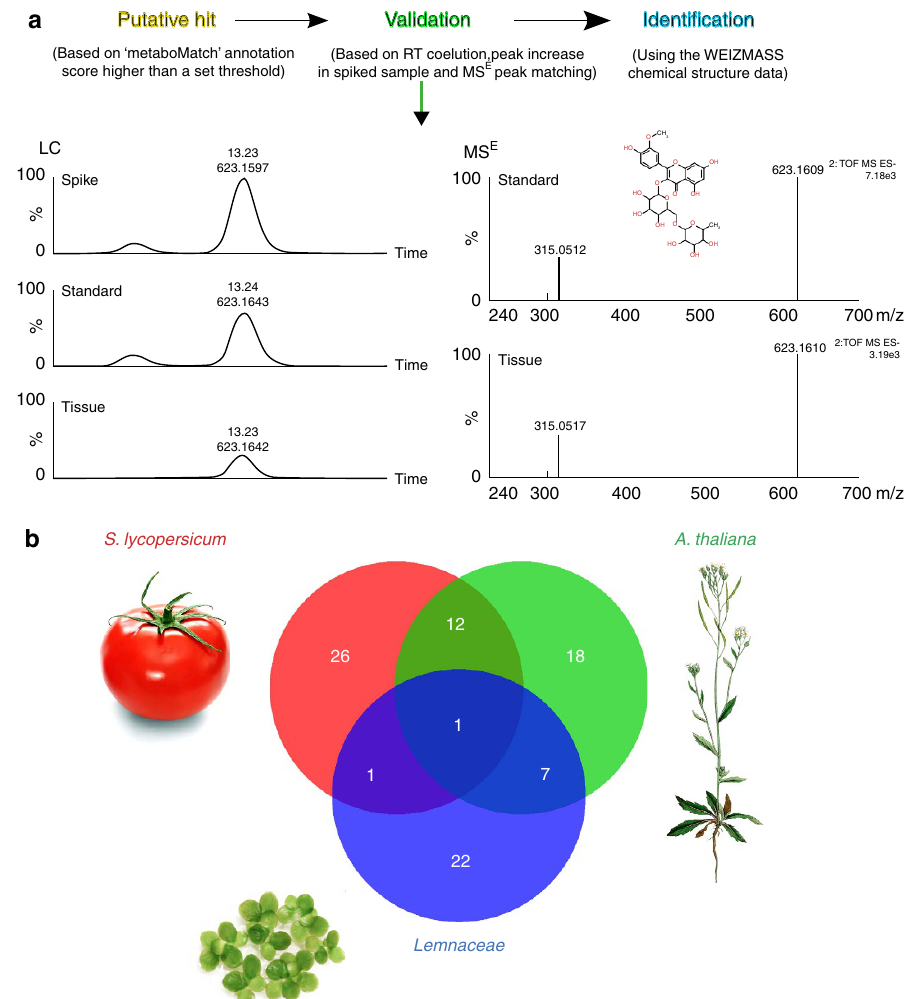
Figure 3 | Validation and high-confidence identification of metabolites. ( a ) Putative hits are experimentally confirmed using three consecutive injections consisting of the endogenous tissue samples, the tissue samples spiked with the corresponding chemical standards and the pure chemical standards. ( b ) A Venn diagram presenting the total counts of annotated metabolites for tomato (red), A. thaliana (green) and members of the Lemnaceae family (blue). Tomato image courtesy of Fir0002/Flagstaffotos under GFDL v1.2 license. Arabidopsis image courtesy of http://delta-intkey.com/angio/ www/crucifer.htm (ref. 49). The photo of Lemna plant was produced